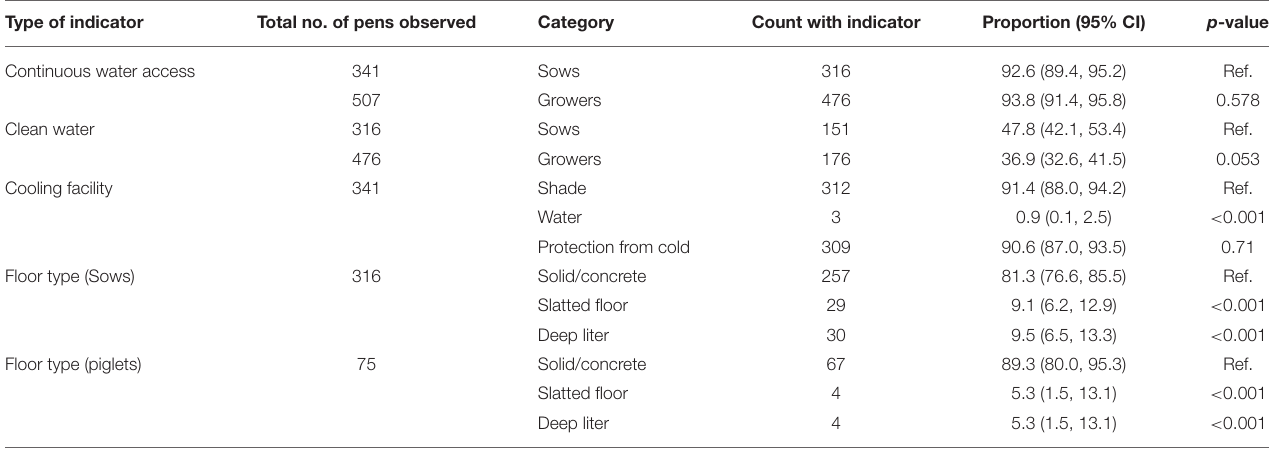
TABLE 9 | Resource based welfare indicators.